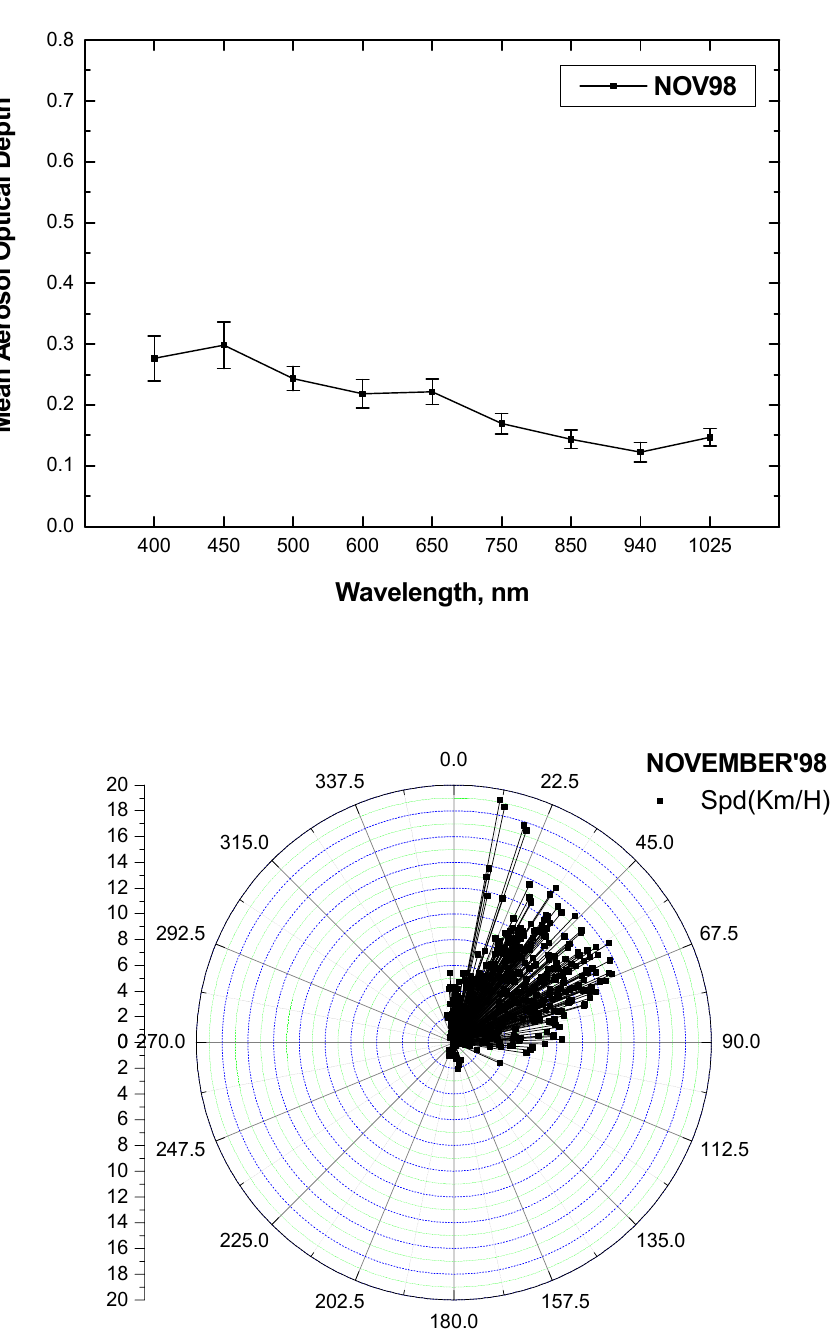
Fig. 5. Mean spectral variation of aerosol optical depth during a typical winter month (November 1998). The bottom panel shows the hourly mean wind speed and direction on the days considered in evaluating the mean AOD shown in the top panel.